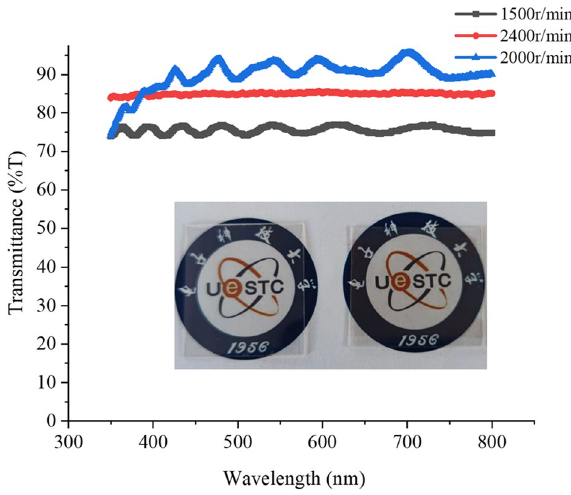
Figure 5. The transmittance of copper network films with different coating speed.